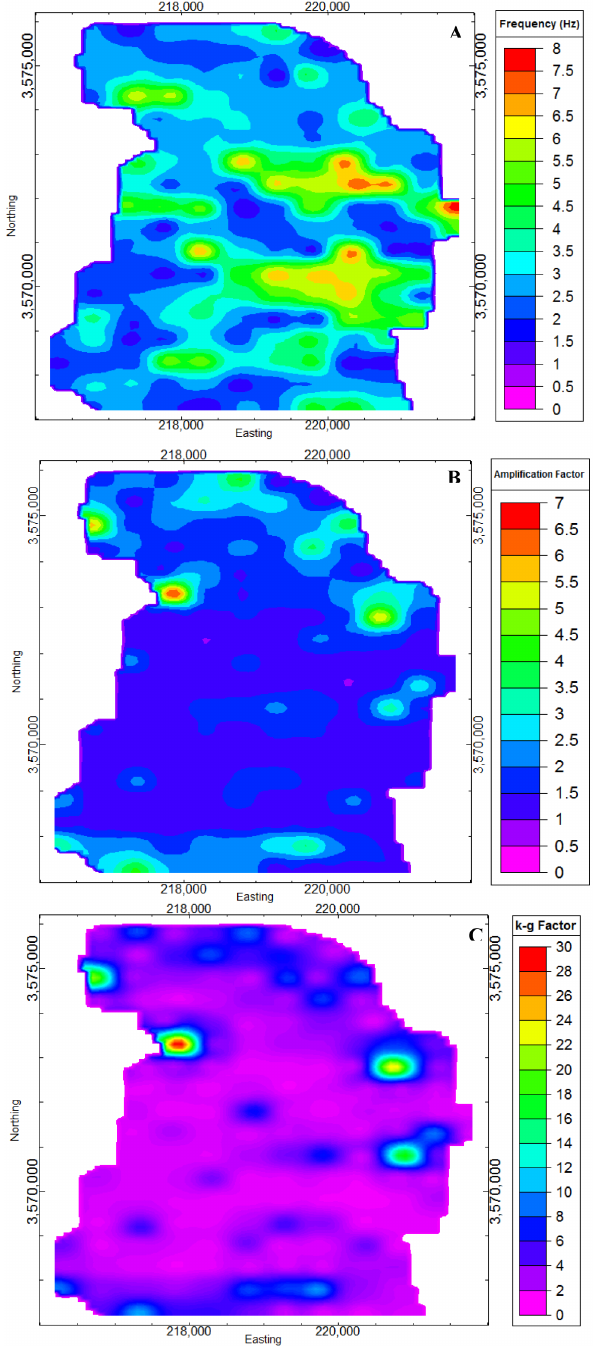
Figure 4. Data distribution maps of Meybod city: (a) frequency; (b) amplification; (c) K - g value.